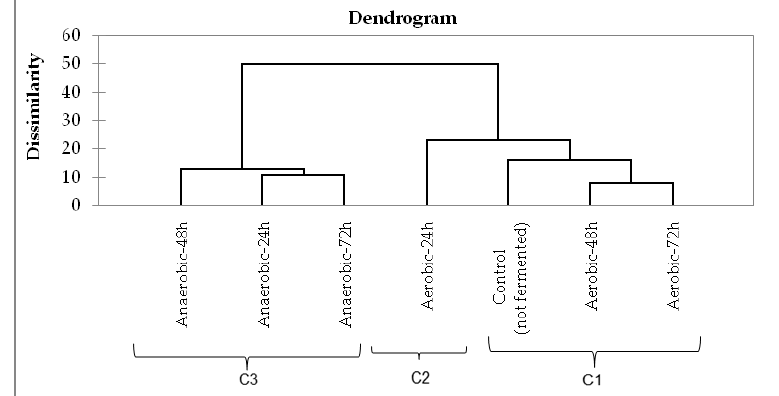
Figure 2. Cluster dendrogram for organic willowherb samples fermented under the different solid-phase fermentation method and different duration, based on 20 variables. These samples are grouped using Ward’s method and Euclidean distance. Conditions of solid-phase fermentation: different fermentation method (Control (not fermented), aerobic solid-phase fermentation method (Aerobic) and anaerobic solid-phase fermentation method (Anaerobic)) and different fermentation duration (Control (not fermented), fermented 24 h, 48 h, and 72 h).